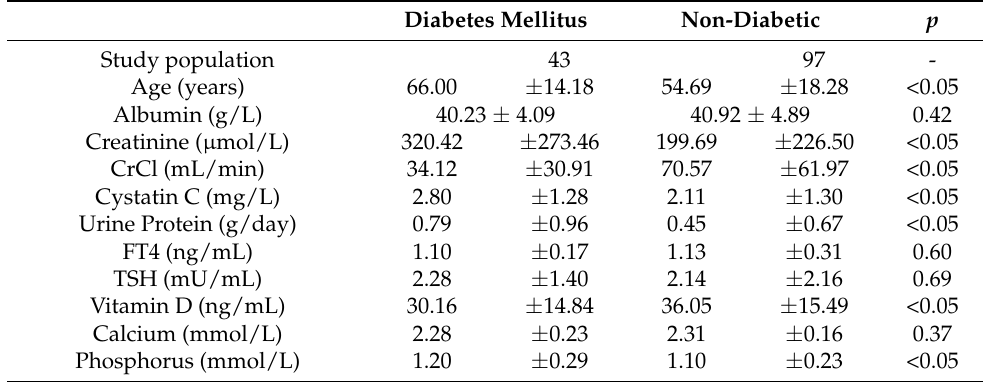
Table 4. Demographics and biochemical characteristics in diabetic vs. non-diabetic patients with chronic kidney disease. Diabetes Mellitus Non-Diabetic p Study